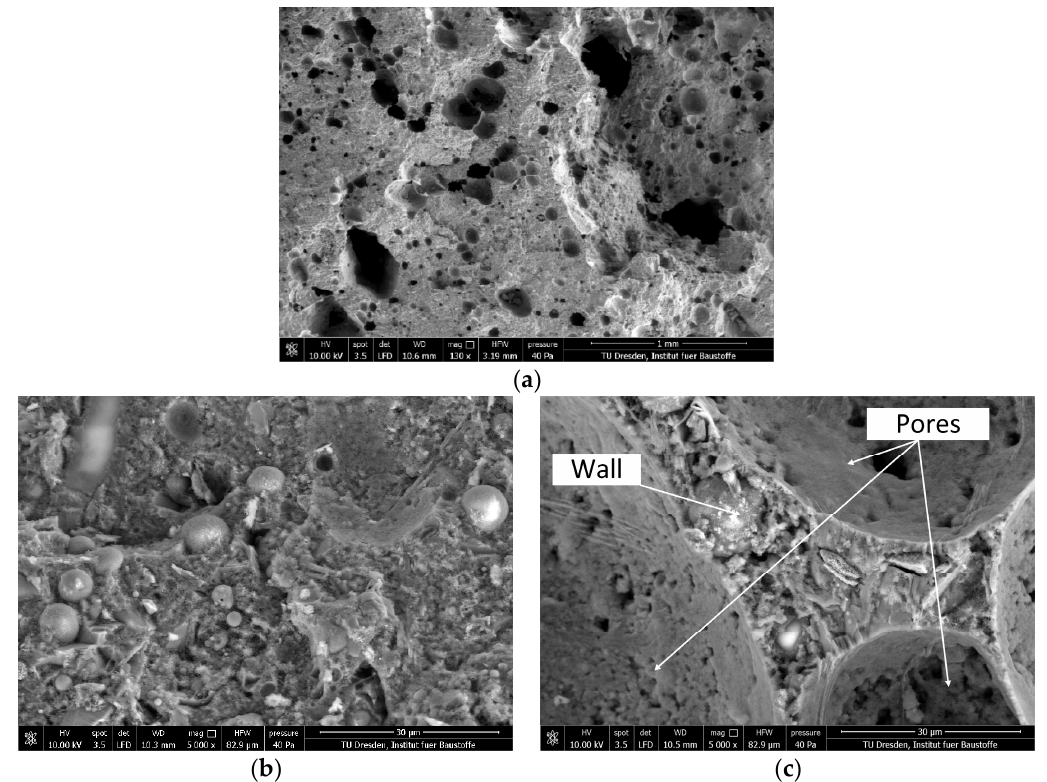
Figure 11. SEM pictures of the foam concrete M-2: ( a ) distribution and structure of pores, ( b ) matrix A-1 used for production of M-2, and ( c ) segment of the wall between pores.